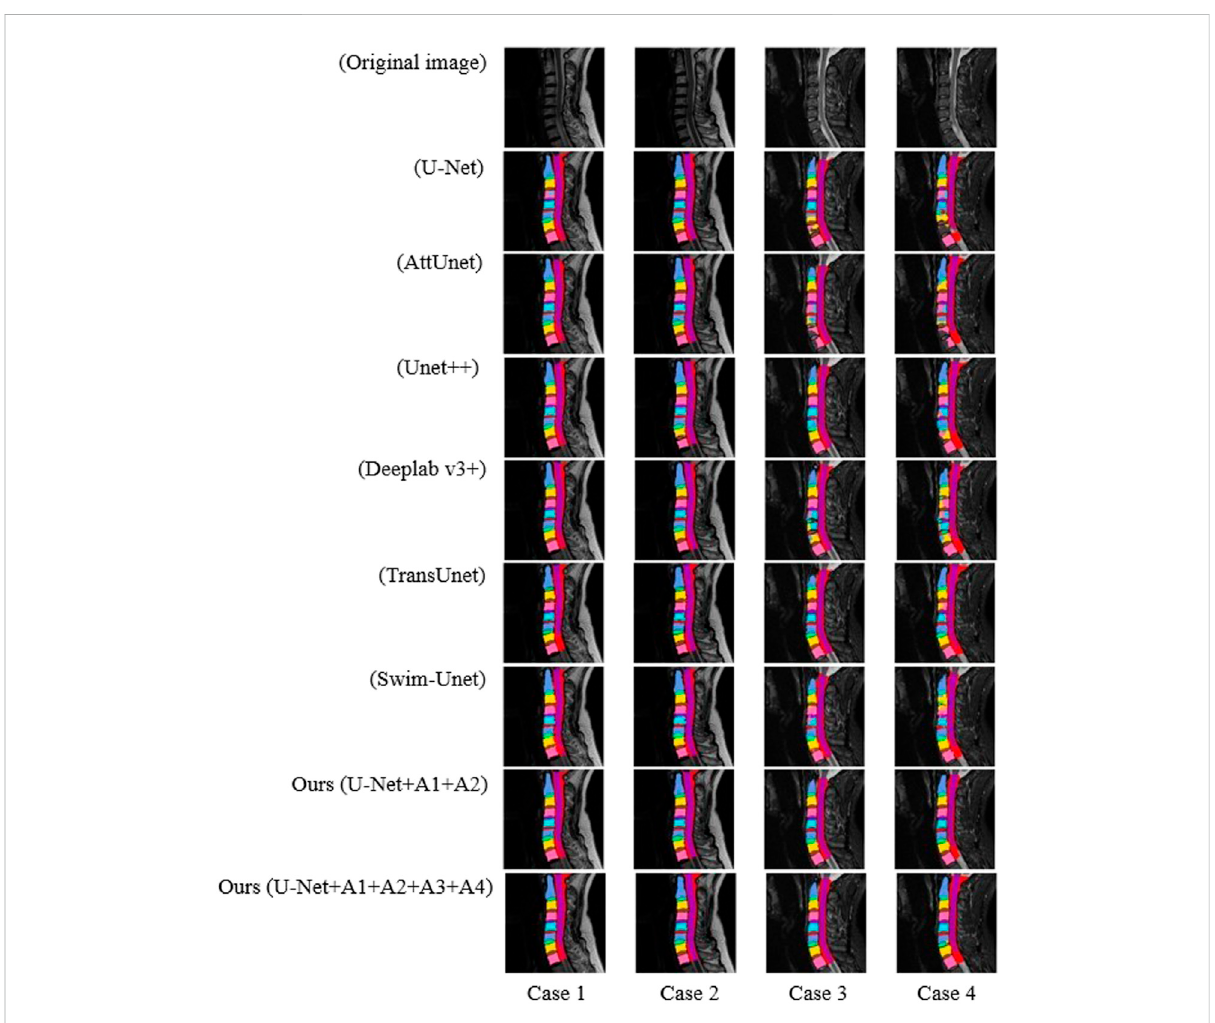
FIGURE 8 Segmentation effect on different models for two patients with a total of four legends.